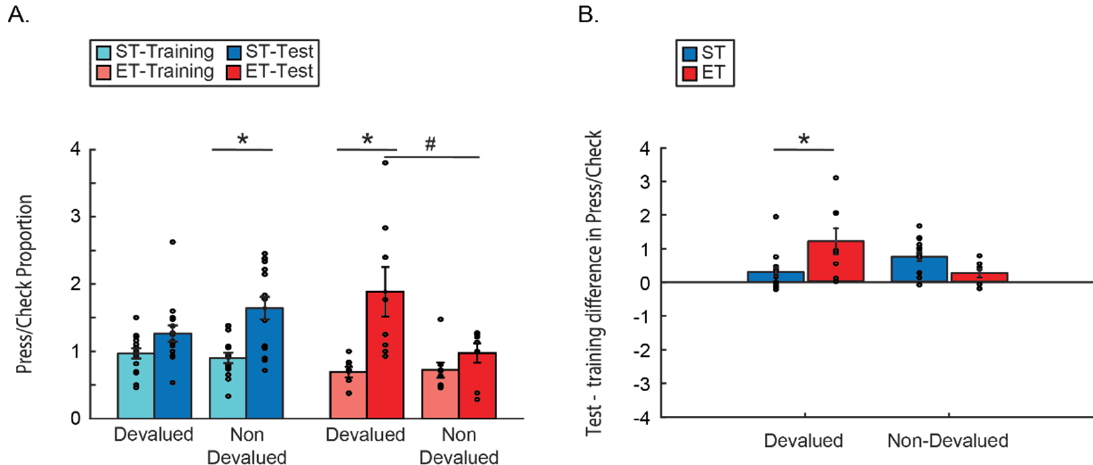
Figure 3. Lever press/magazine-checks proportions on the test following devaluation training. All following figures are bar plots with error bars (standard error) overlaid with the dots of raw data of each mouse. Blue represents the short training group (ST) and red represents the extended training group (ET). In each group the lighter color represents the last day of training and the darker color—the test. Asterisk represents significance of p < 0.05. Hash (#) represents a statistical trend (0.1 > p > 0.05). ( A ) Comparison of the proportions between training groups, reward type, and time. ( B ) Comparison of the difference (subtraction) between the test day and the last day of training in each mouse proportion between training groups and reward type.